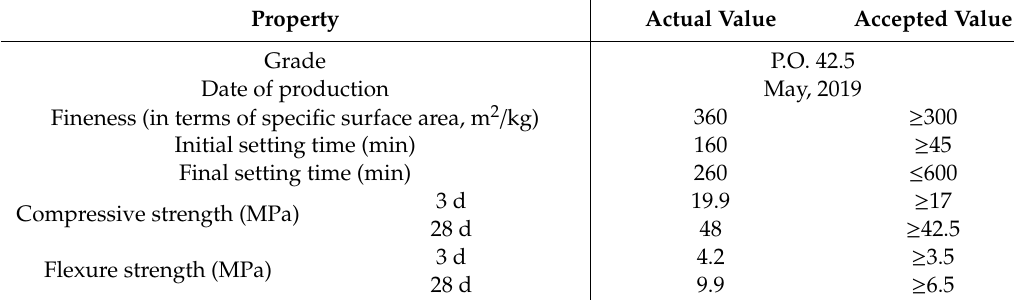
Table 3. Physical and mechanical properties of cement.